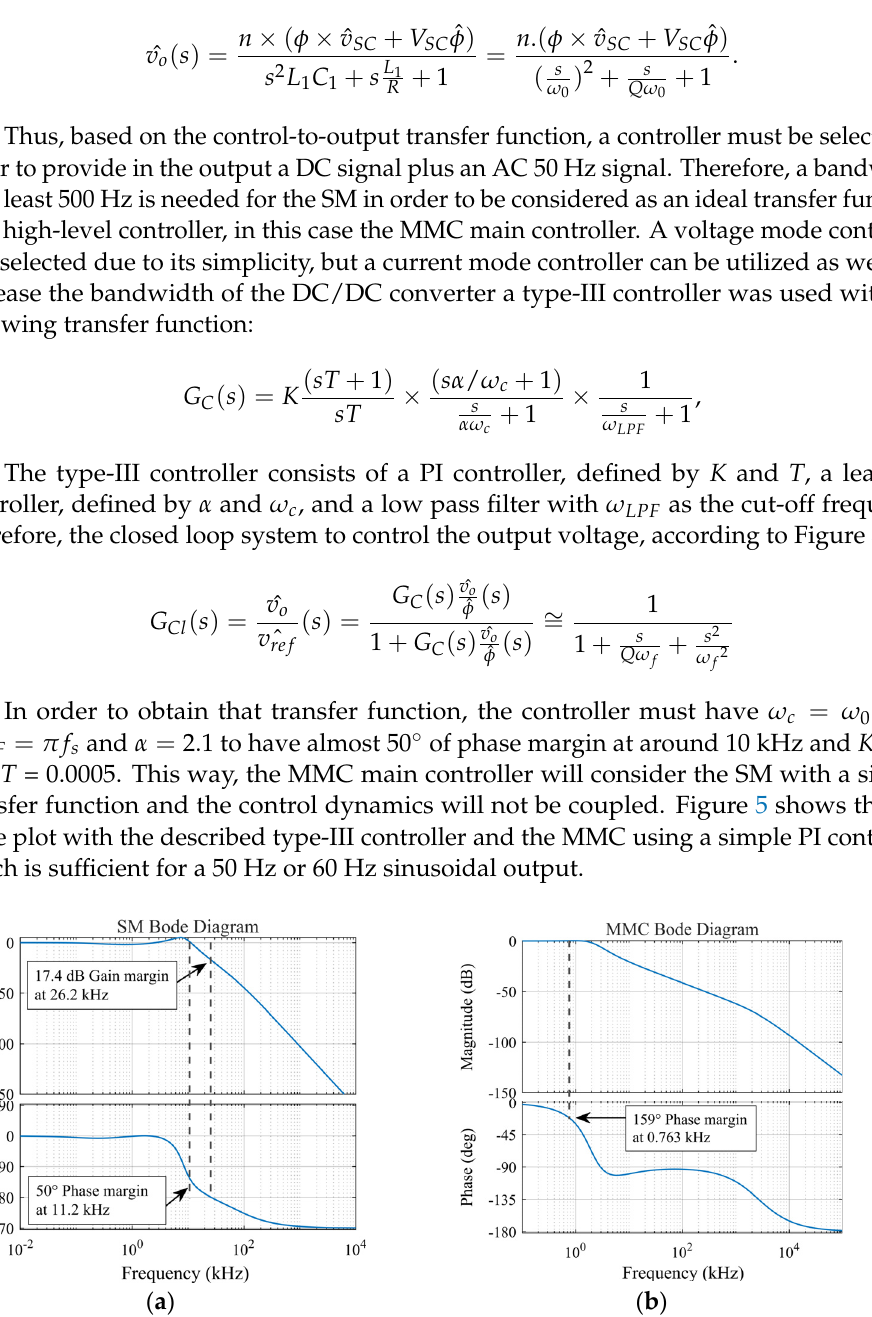
Figure 5. Closed loop transfer function for: ( a ) SM using a type-III controller and ( b ) MMC using a PI controller.